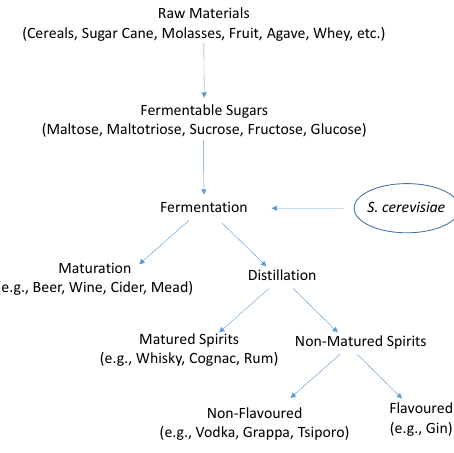
Figure 1. The key roles of Saccharomyces cerevisiae in production of fermented beverages. Table 1. The main types of yeast used in the production of selected alcoholic beverages.